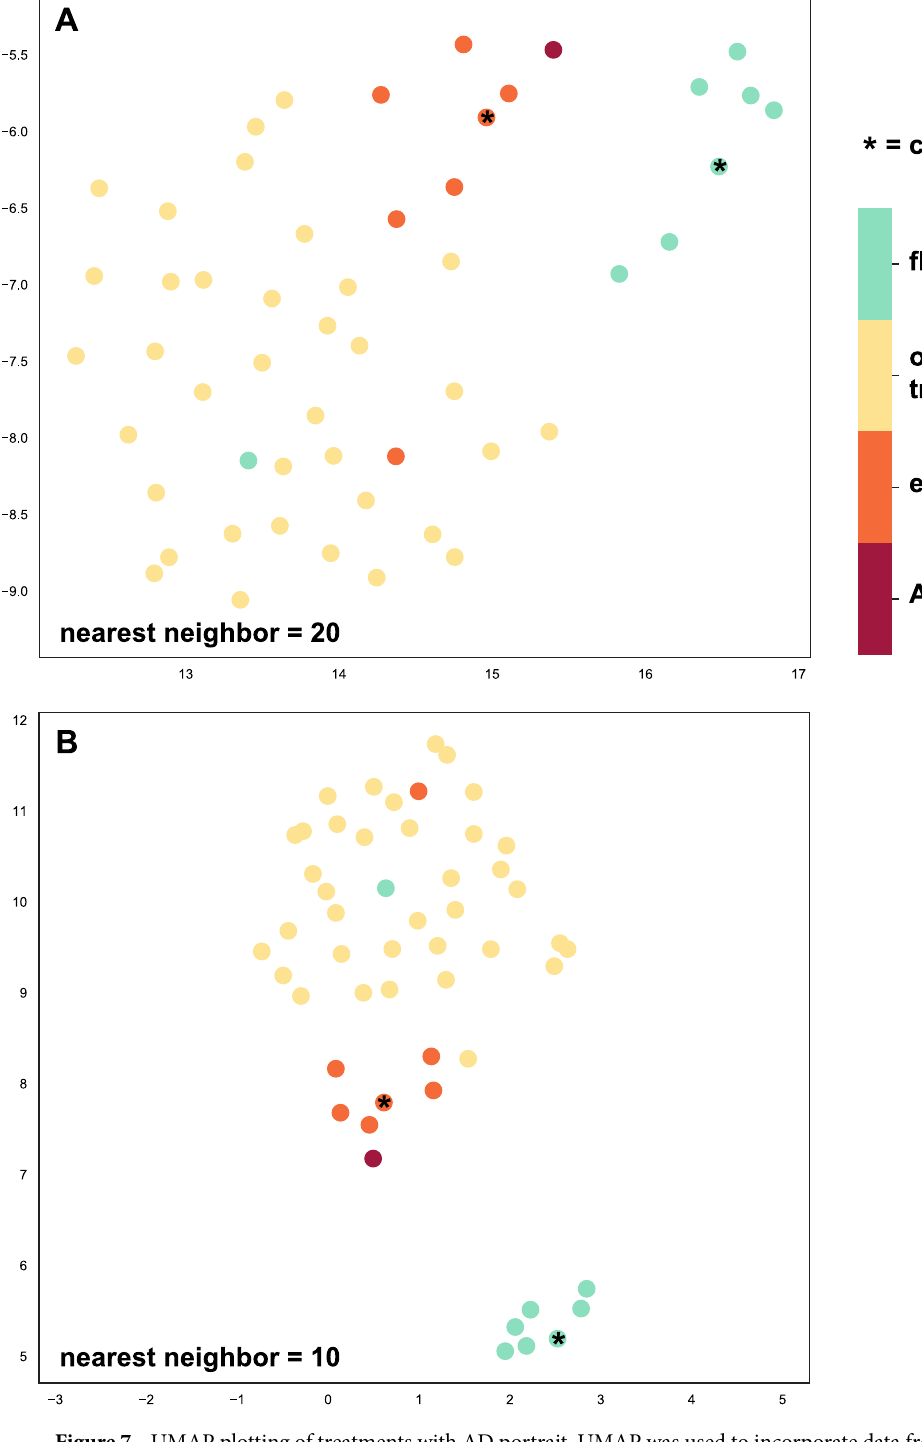
Figure 7. UMAP plotting of treatments with AD portrait. UMAP was used to incorporate data from complex landscape of multidimensional features (5862 genes) and flatten those to two dimensions to identify similarities between datasets. The sign for the AD portrait was reversed so that a closer distance (spatial proximity) of a treatment (top 51 plotted) to the portrait represents a better match (reversal of pattern). Plot represents higher dimension data plotted into two dimensions. The x ‐ and y ‐ axes are arbitrary embedding dimensions generated by UMAP. Top graph ( A ) is from plotting using the neighborhood setting of 20 and lower graph ( B ) uses the setting of 10. The AD portrait was most closely associated with the exercise datasets, but was also close to the fluoxetine treatments. Colored dots are: dark red (AD portrait); orange (exercise); tan (other top treatments); turquoise (fluoxetine). The fluoxetine and exercise composites are denoted with an